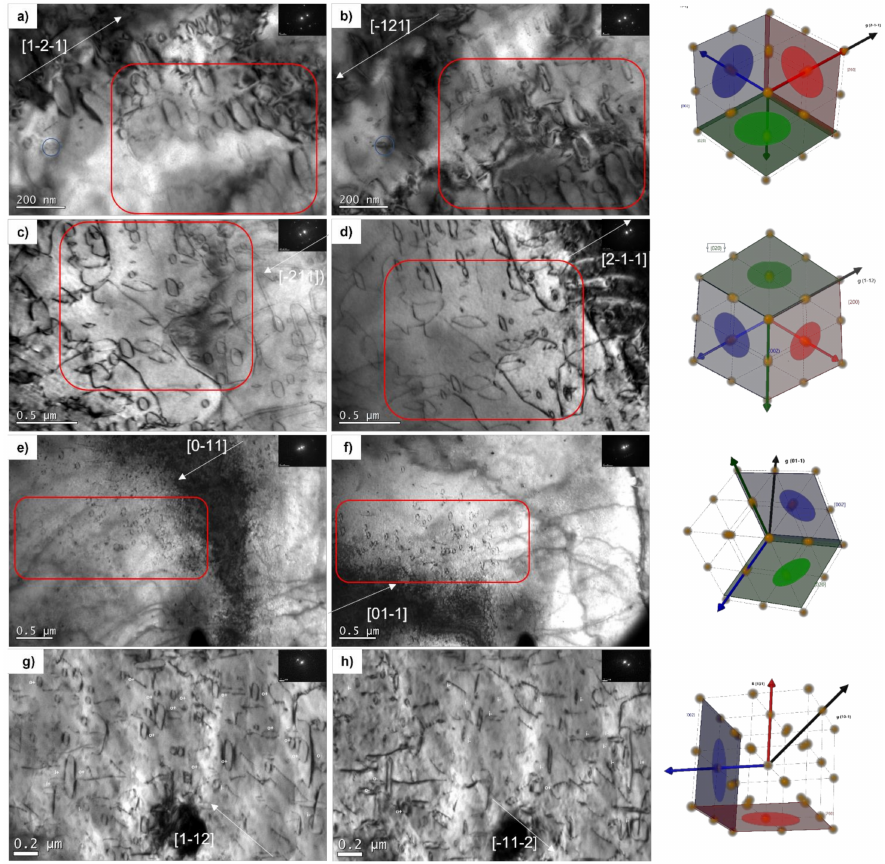
Figure 23. Inside–outside method to study the nature of the visible loops at ( a , b ) low dose and 300 ◦ C; ( c , d ) low dose 450 ◦ C; ( e , f ) high dose 300 ◦ C; and ( g , h ) high dose and 450 ◦